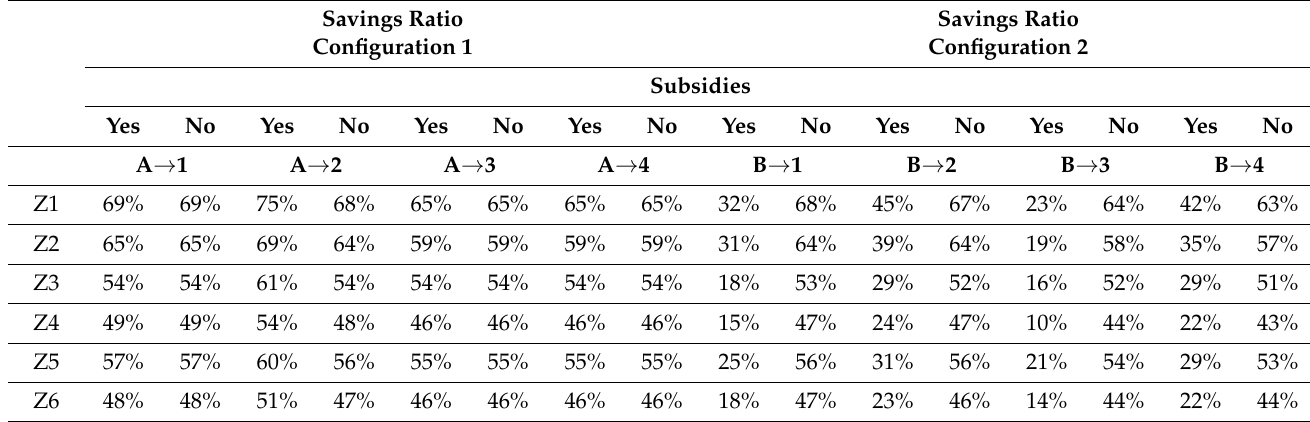
Table 18. Savings using the active system SWH.